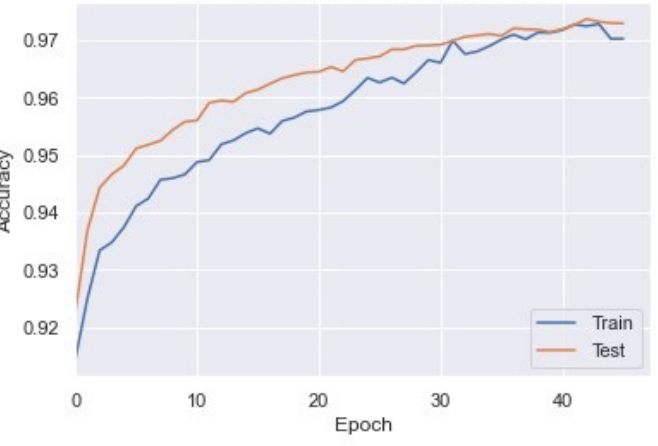
Figure 12. Training and test accuracy of LSTM model for DDoS